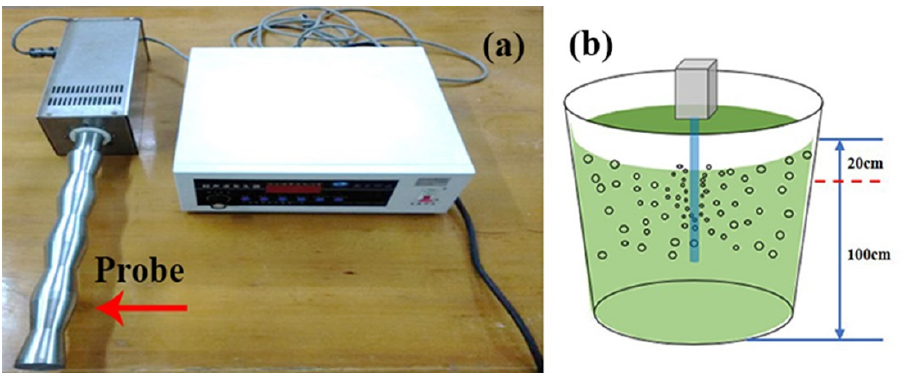
Figure 1. ( a ) The sonication instrument; ( b ) The schematic of sonication